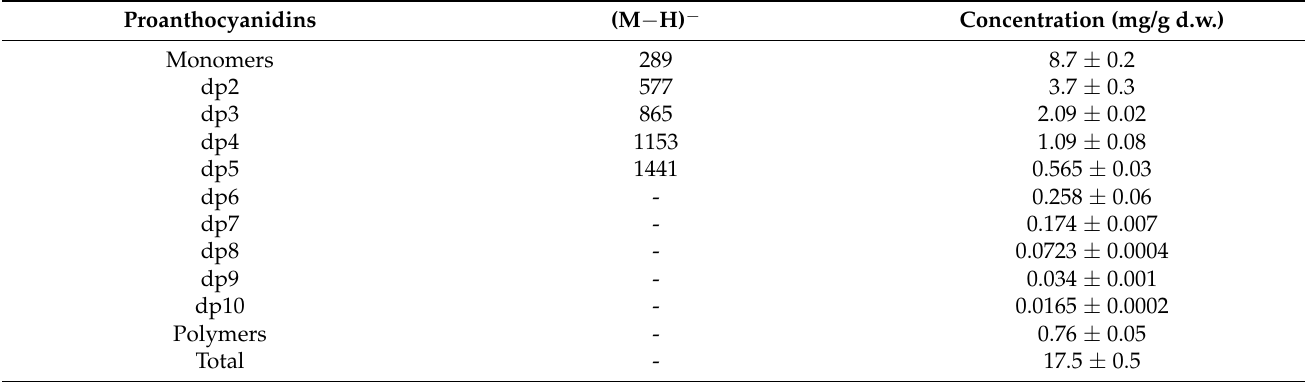
Table 6. Identification and quantification of proanthocyanidins from C. monogyna optimum leaf extract by HPLC-ESI-TOF- MS and HPLC-FLD. The results are expressed as mg · g − 1 d.w. Proanthocyanidins (M − H) − Concentration (mg/g d.w.)